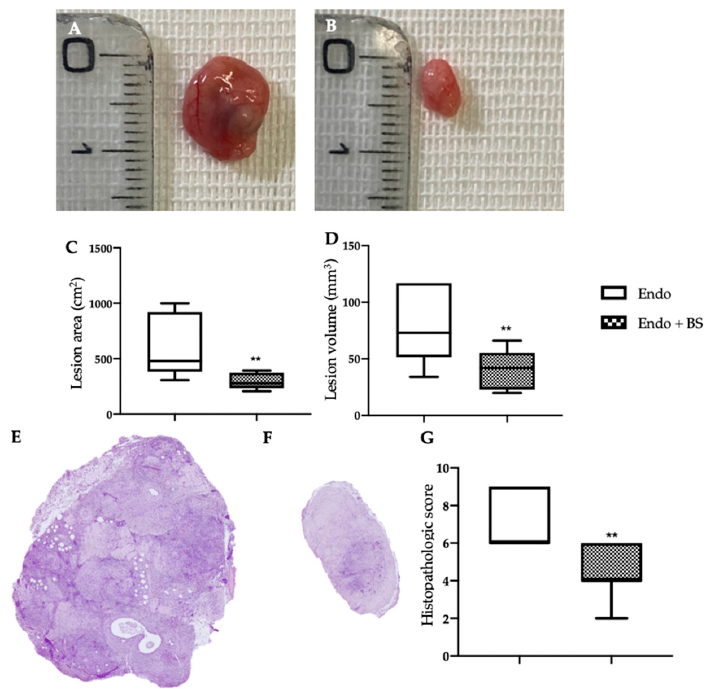
Figure 2. Analysis of the effect of oral BS administration on lesions size and histology: Macroscopic analysis: EMS ( A ), EMS + BS ( B ); lesion area ( C ); lesion volume ( D ); histological analysis: EMS ( E ), EMS + BS ( F ), histopathologic score ( G ). For the analyses, n = 5 animals from each group were employed. A p -value of less than 0.05 was considered significant. ** p < 0.01 vs. control.